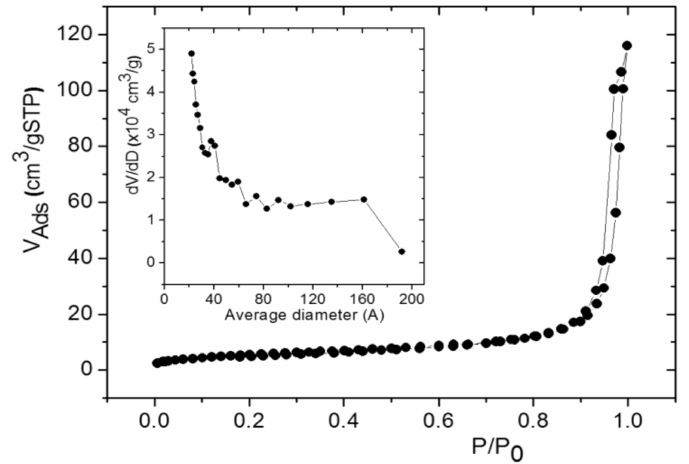
Figure 4. The nitrogen adsorption-desorption isotherm for FO sample. Inset shows the corresponding pore size